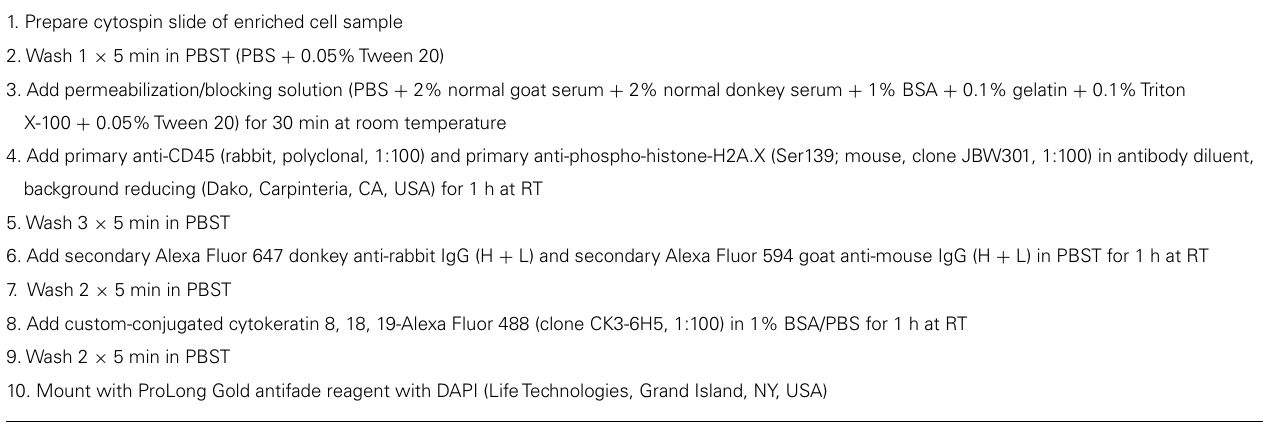
Table 2 | Optimized labeling protocol.